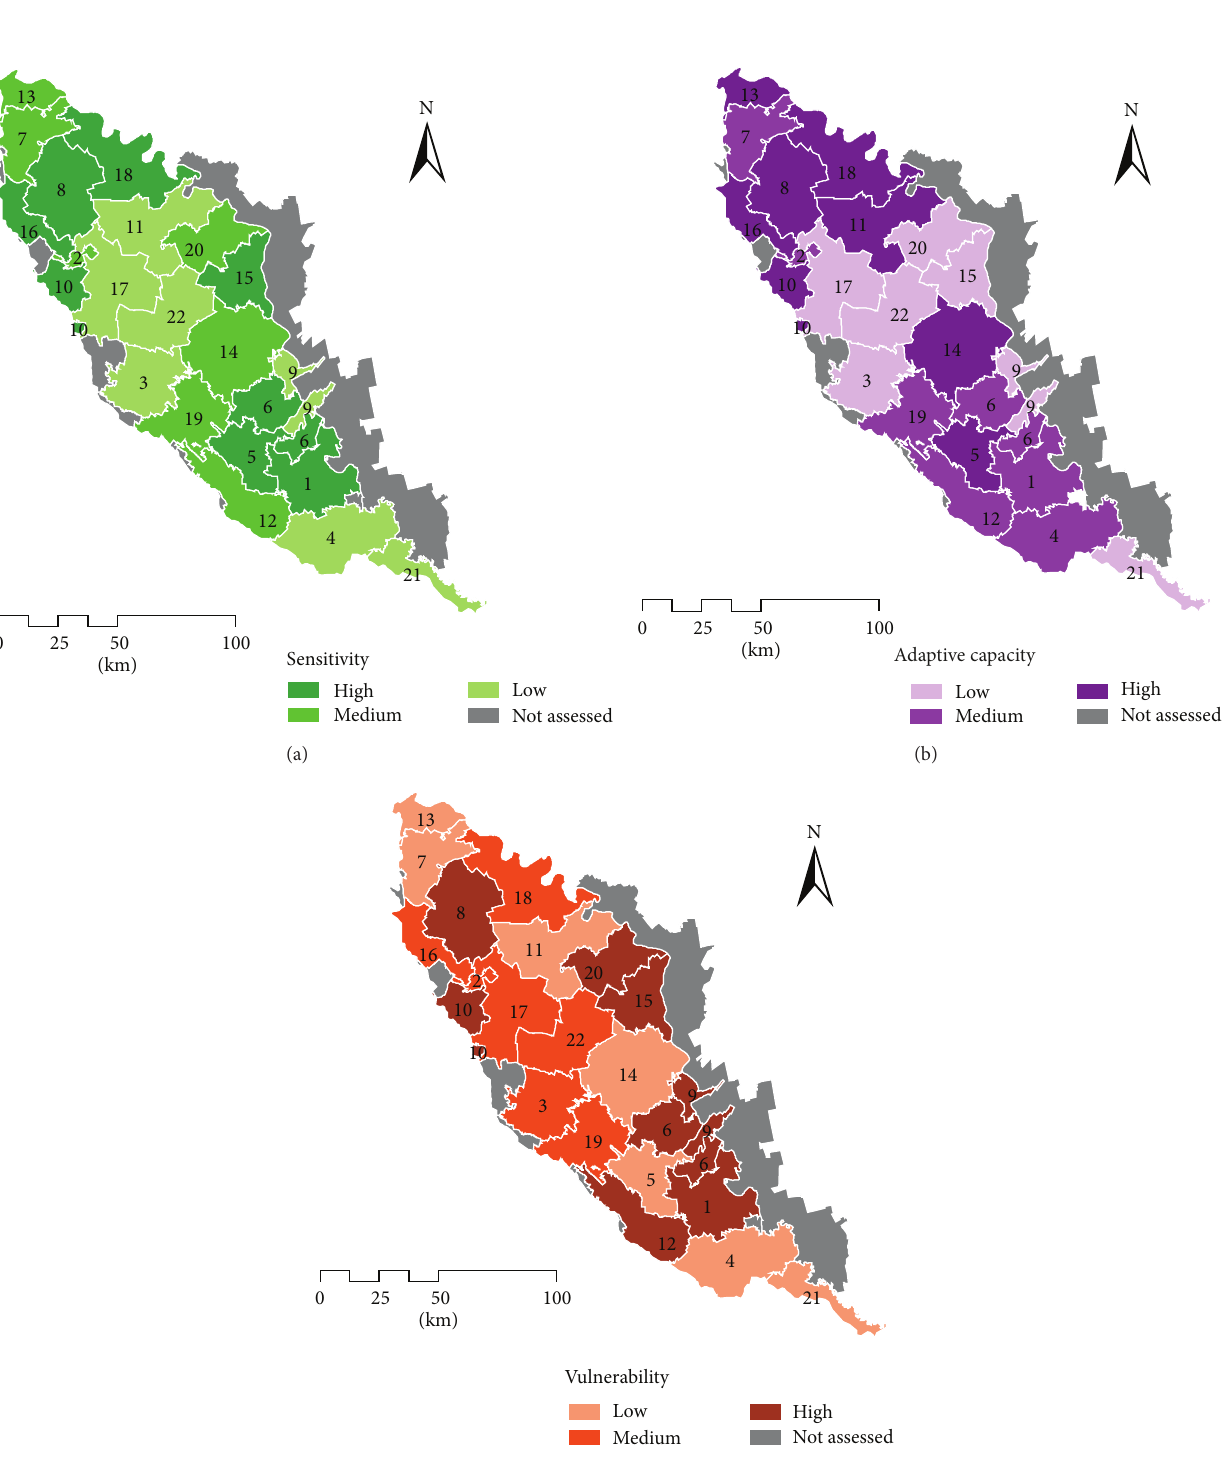
Figure 3: Vulnerability to climate change (c) of Moldova’s administrative-territorial units as a function of their sensitivity (a) and adaptive capacity (b). Notes: (1) numbering of ATUs is made according to Table 4; (2) as “not assessed” there are shown raions of Transnistria (due to the lack of an access to relative information in this politically separative region) and those Moldavian west raions, which have just small parts of their territory within the